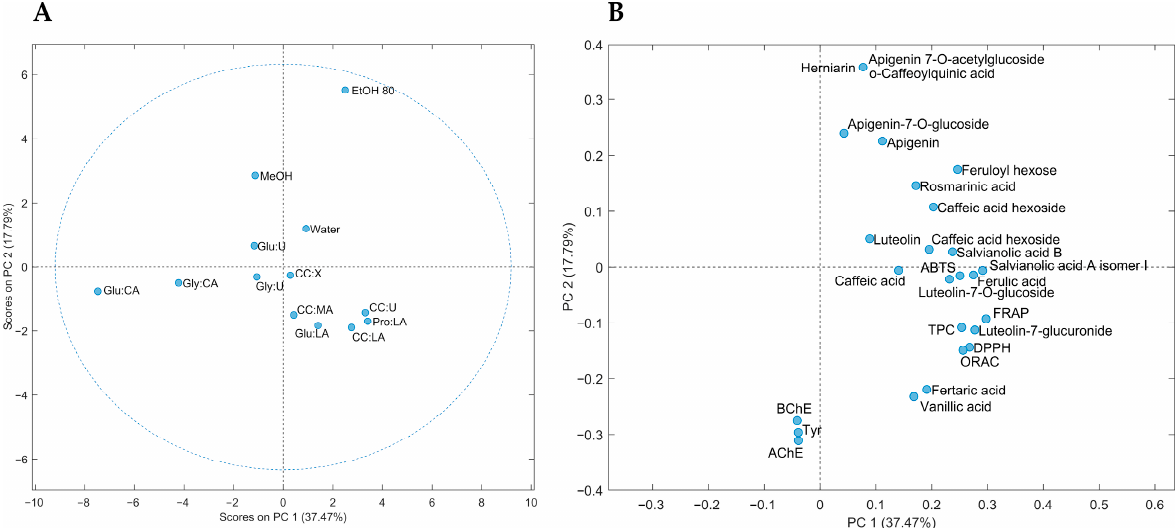
Figure 4. Score plot (A) and loading plot (B) of principal component analysis (PCA) of extracts from Lavandula pedunculata subsp. lusitanica using NADES and conventional solvents.